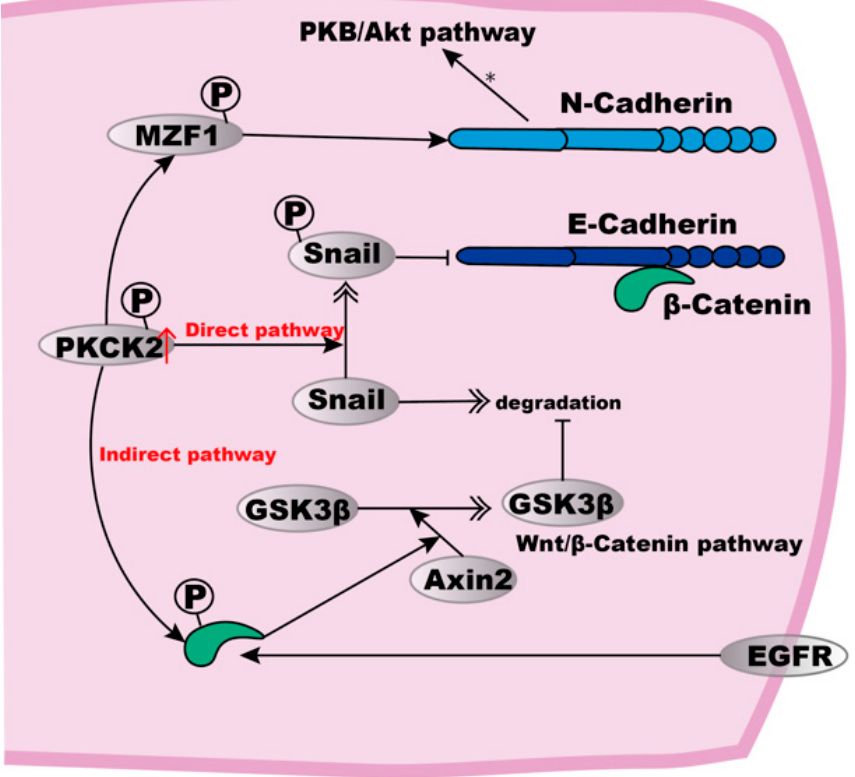
Figure 2. E- to N-Cadherin transition in ESCC cells. High expression of PKCK2 can induce E- to N-Cadherin transition. In a direct way, PKCK2 phosphorylation stabilises Snail, which then inhibits